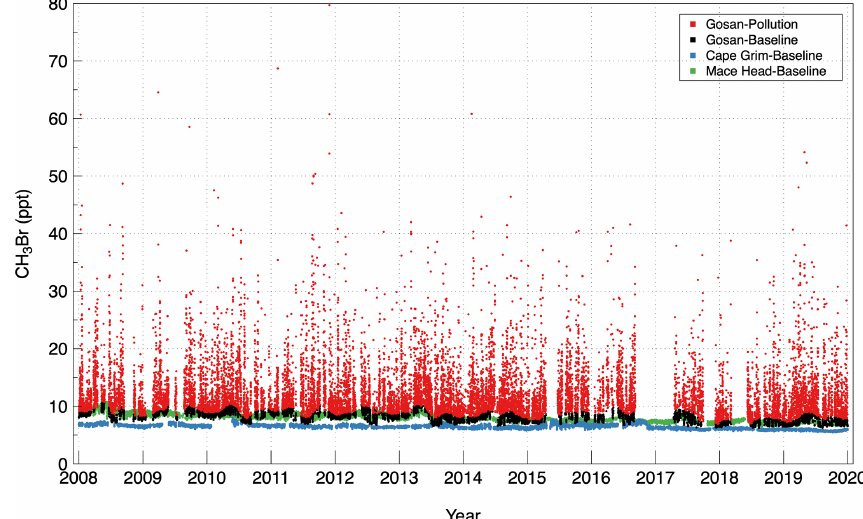
Figure 2. Mole fractions of CH 3 Br in the atmosphere at Gosan for the period 2008–2019. The baseline data (black) are selected using a statistical method (O’Doherty et al., 2001); the polluted data (red) are elevated above the baseline data. The baseline data from Mace Head, Ireland (green), and Cape Grim, Australia (blue), over the same period are shown as mid-latitude references for the Northern Hemisphere and Southern Hemisphere, respectively.